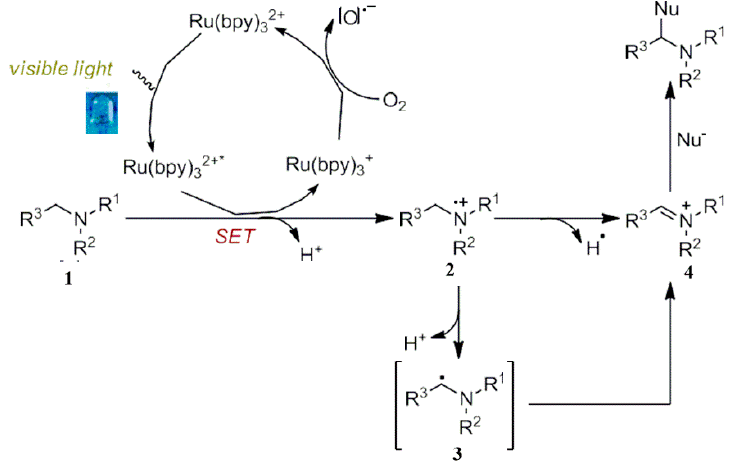
Scheme 4. Visible light catalytic oxidation for the production of imine ion intermediates.